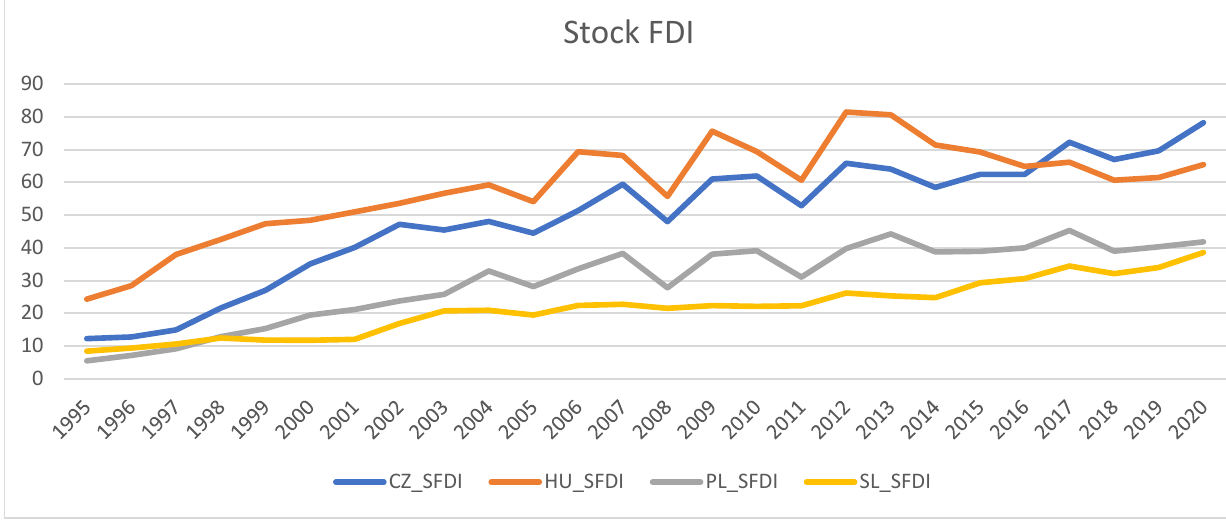
Figure 1. Evolution of stocks of FDI inflows (% of GDP) in the Czech Republic, Hungary, Poland and Slovenia in the period 1995 – 2020.